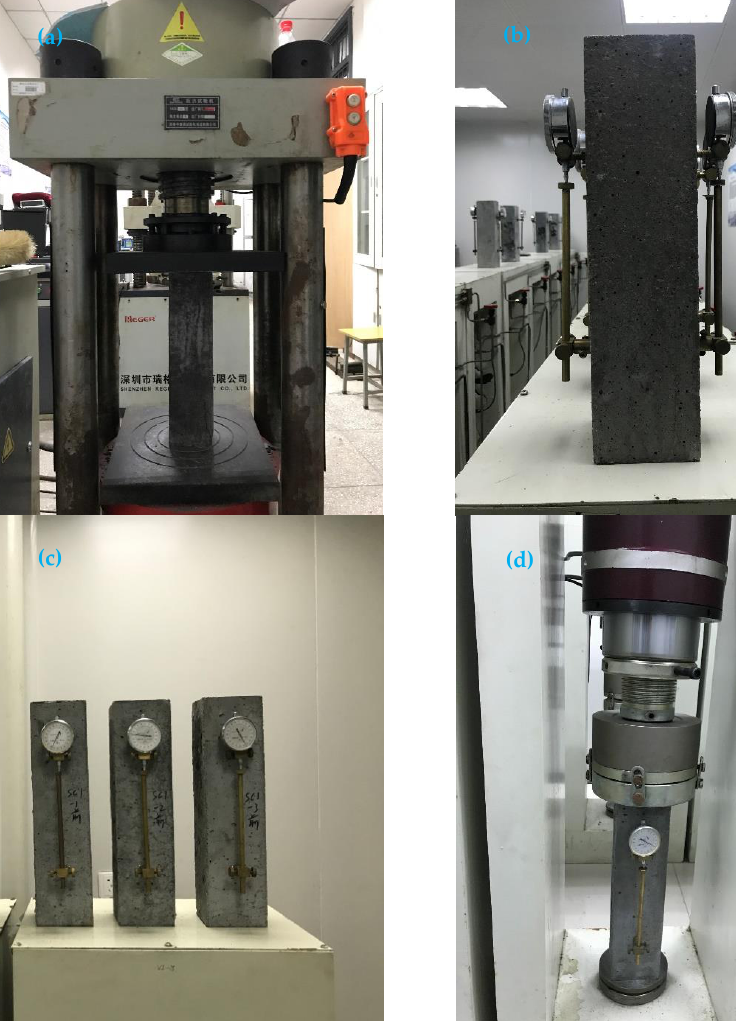
Figure 3. Experiment procedure: ( a ) concrete axial compression test; ( b ) micrometer gauge installation; ( c ) concrete shrinkage test; ( d ) concrete creep test.